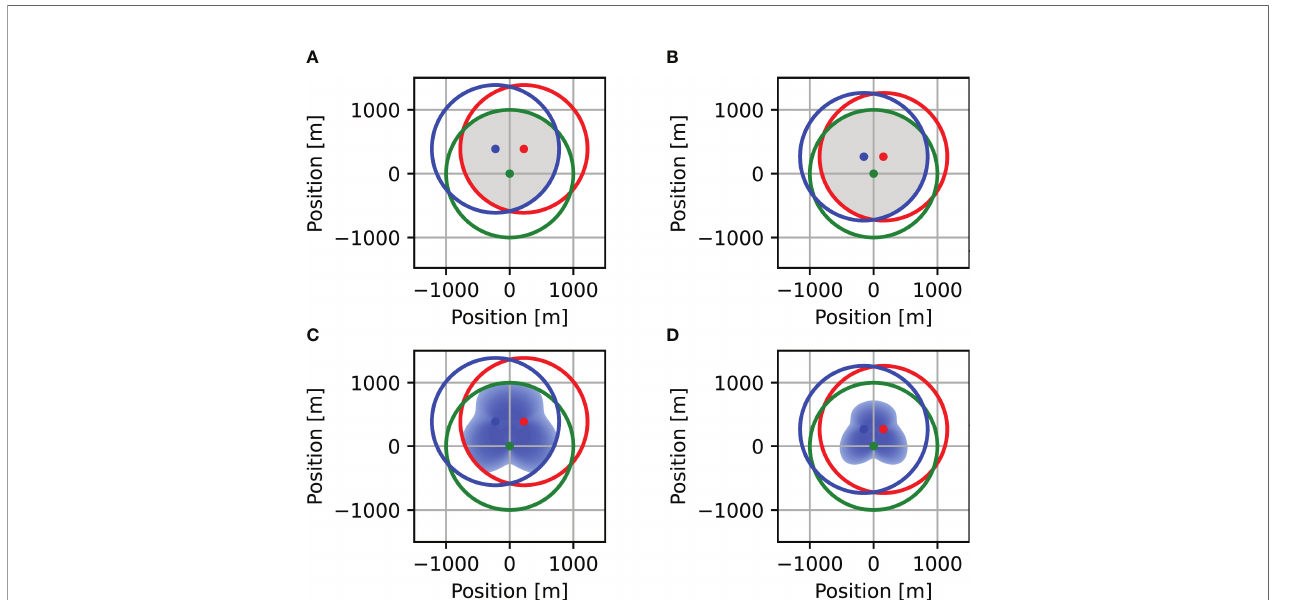
FIGURE 7 | Effect of distance between the receivers on the usable area and the coverage area with attained positioning quality. In setup 1, plots (A, C) , the receivers are placed 450 m away from each other creating a usable area of S ≈ 1.782 km 2 and the coverage area is C ≈ 1.544 km 2 occupying 86% of the usable area. In setup 2, plots (B, D) , the receivers are placed 300 m away from each other creating a usable area of S ≈ 2.1472 km 2 . For this setup, the receivers are closer to each other than in Setup 1, and the coverage area is C ≈ 0.791 km 2 , occupying only 37% of the usable area. The usable area in plots (A, B) is highlighted in gray. The coverage area, plots (C, D) for GDOP ≤ 5 is highlighted in light blue.